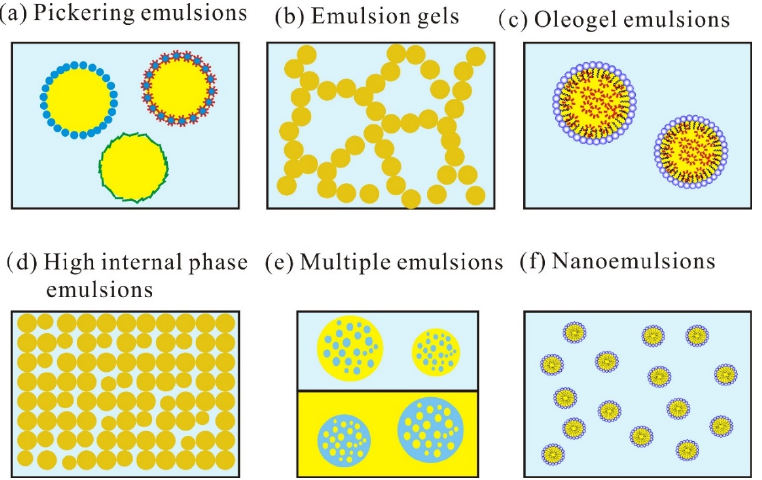
Figure 8. Structures of Pickering emulsions ( a ), emulsion gels ( b ), oleogel emulsions ( c ), high inter- nal phase emulsions ( d ), multiple emulsions ( e ), and nanoemulsions ( f ). Fat